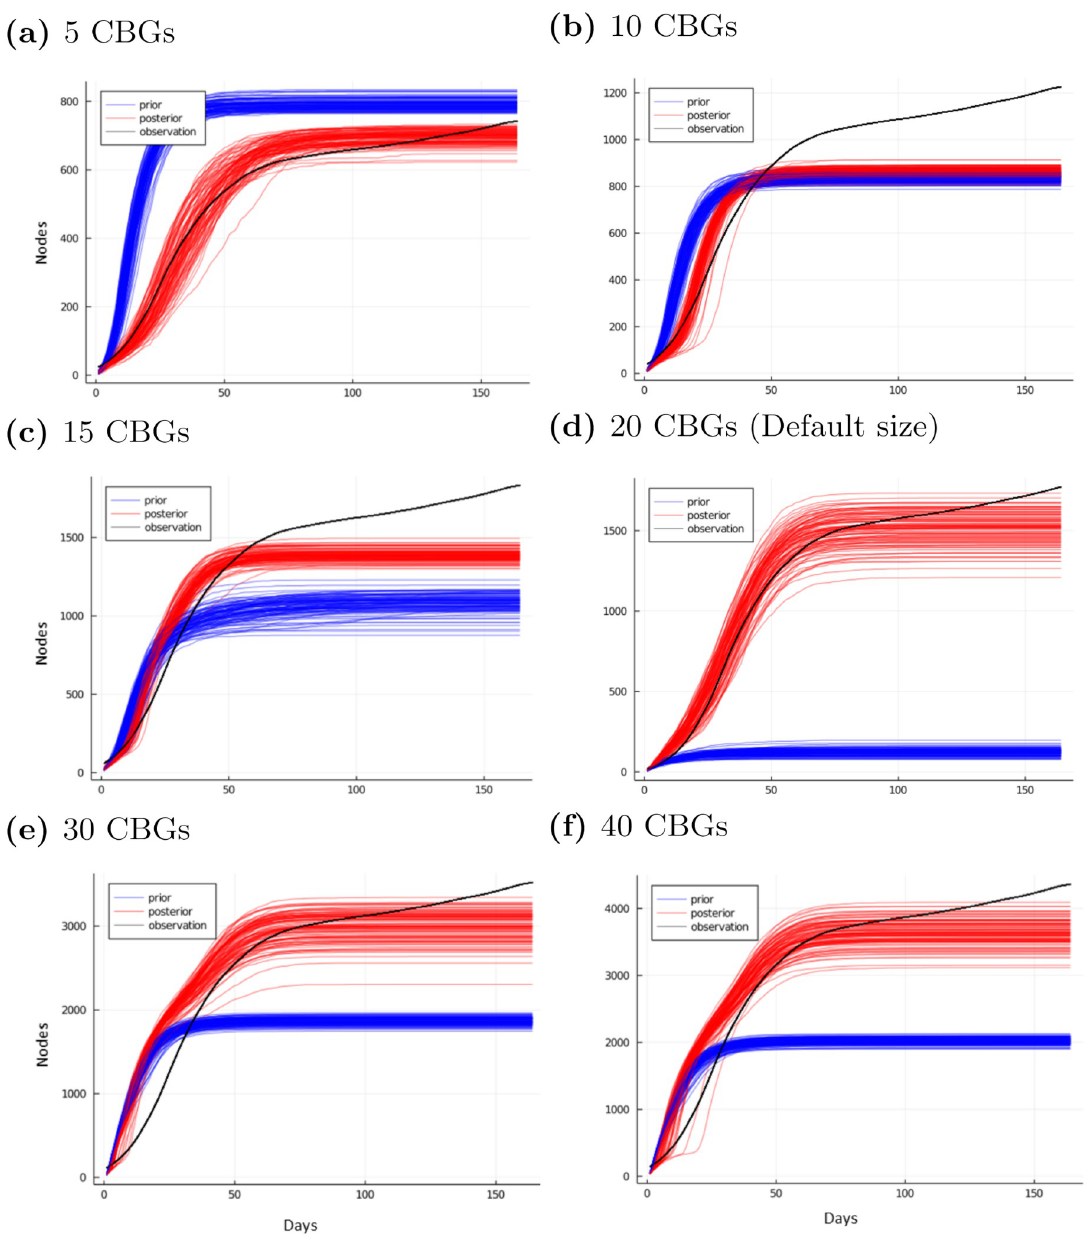
Fig 13. Prior and posterior disease trajectories with varying network size. Applying the same prior parameters on graphs subsampled to a different initial set of CBGs produces substantially different prior behavior for the disease simulator (blue). Our inference converges to a consistent behavior (red) that is close to the observed data